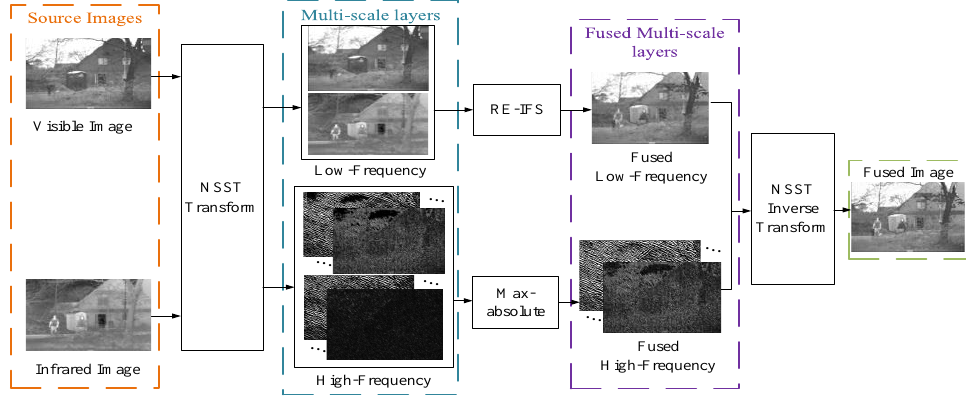
Figure 2. The overall framework of the proposed algorithm.